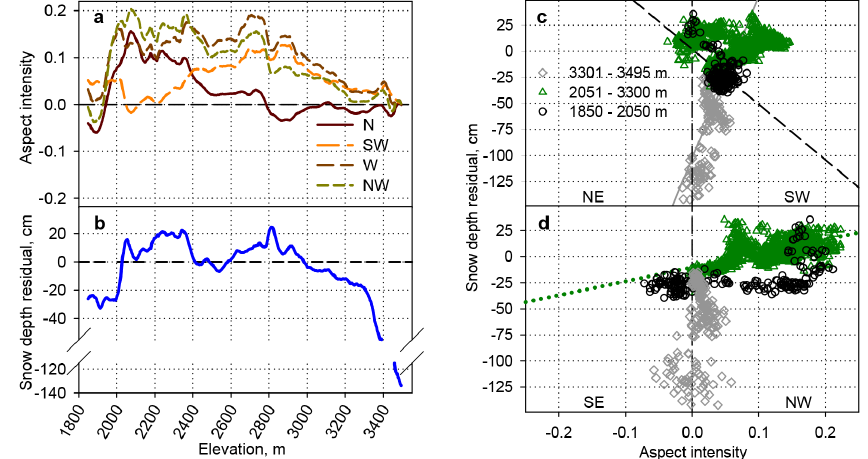
Figure 4. (a) Aspect intensity of LiDAR domain by elevation; (b) residuals of mean 23 March snow depth using model regression of slope, 1850–3300m, from Fig. 2a; (c) regression of residuals for 1850–2050m (black, dashed line) and 3301–3494m (gray, solid line) showing departures from elevation trend for NE and SW aspect intensity; and (d) 2051–3300m (green, dotted line) in SE and NW.